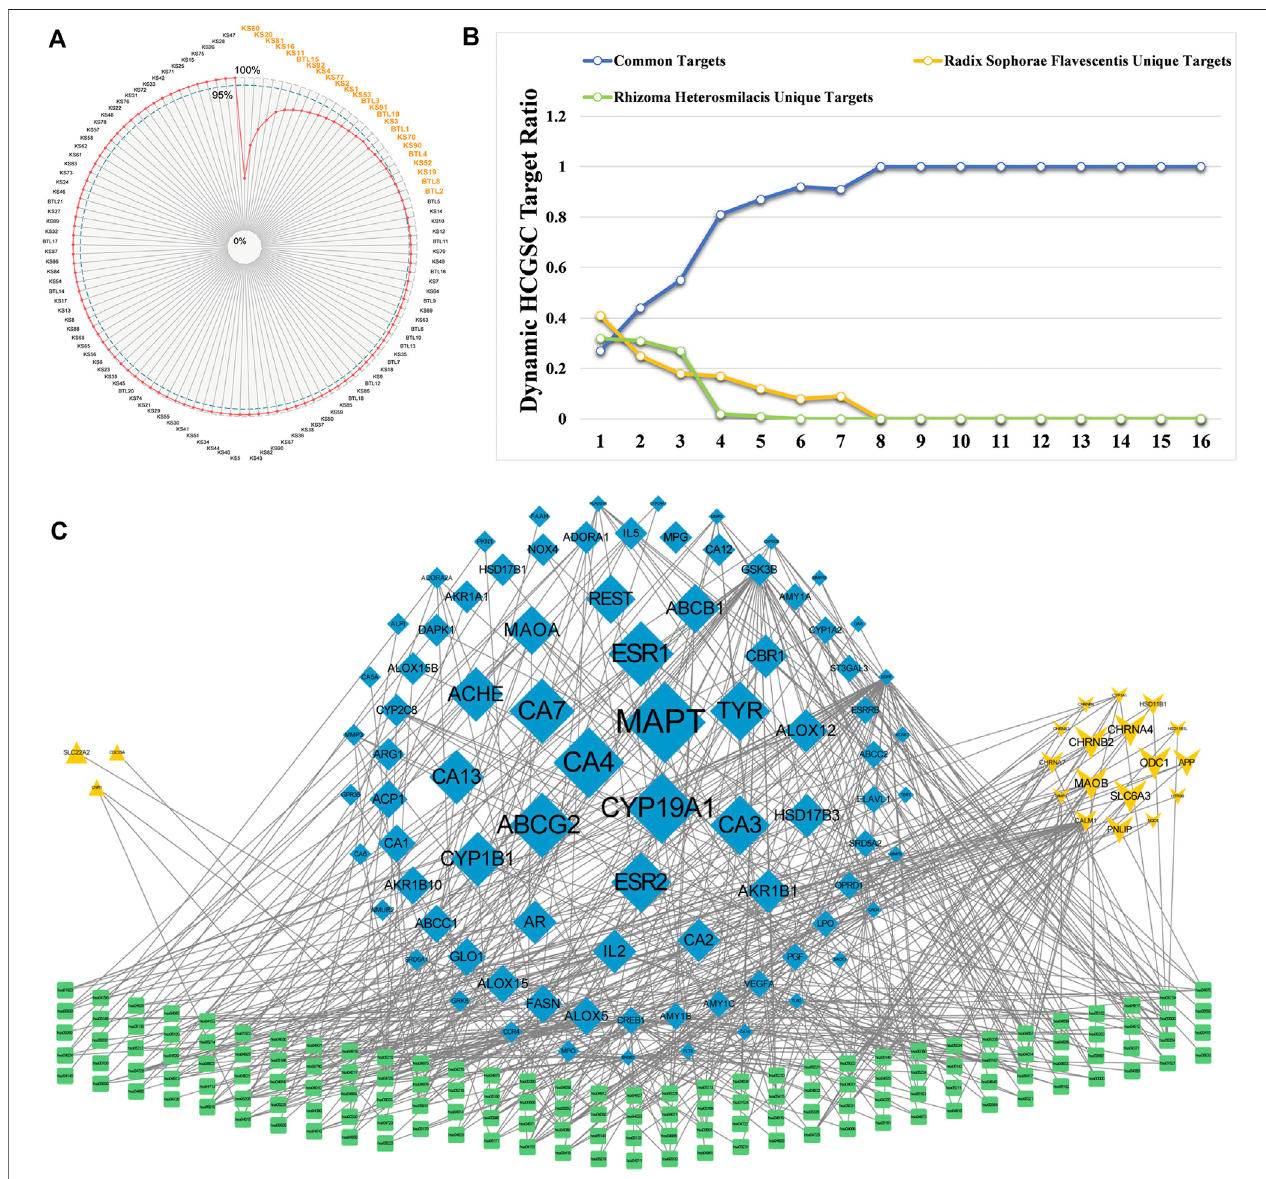
FIGURE4|(A) CumulativeradarchartoftheratiobetweencomponentaccumulationtargetsandthetargetsofCKI.Thelabelwithinthechartrepresentedtheratio (%) between component accumulation targets and the targets of CKI. (B) The dynamic ratio changes between common targets of HCGSC and unique targets of Radix Sophorae Flavescentis, and Rhizoma Heterosmilacis of HCGSC. (C) The network with targets and their enriched pathways (the degrees of the targets were higher than the third quartile of the targets in the C-T network of HCGSC) and their enriched pathways.